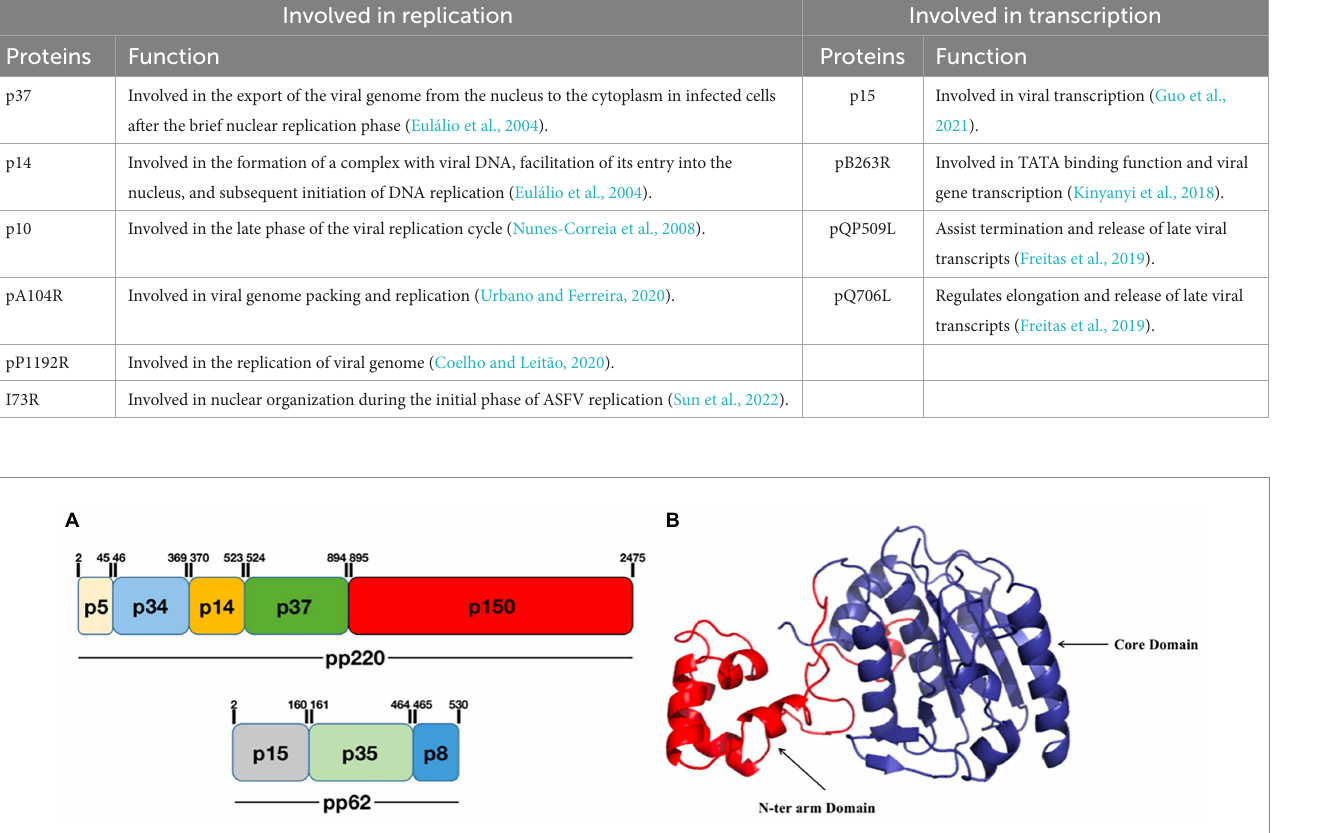
FIGURE 2 Schematic diagram of the ASFV pS273R structure. (A) pS273R catalyzes the hydrolysis of pp220 to p5, p34, p14, p37, and p150, and pp62 to p15, p35, and p8. (B) The pS273R protein consists of an “arm domain” (red) and a “core domain” (dark blue; Li et al.,